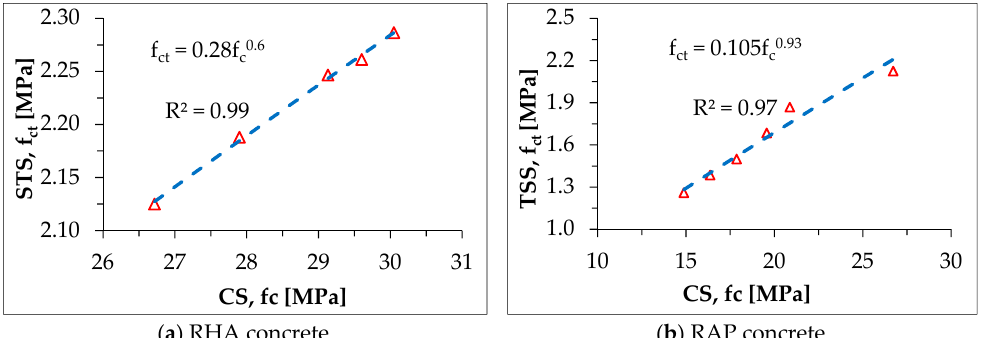
Figure 12. Relationship between CS and TSS for RHA and RAP concrete.